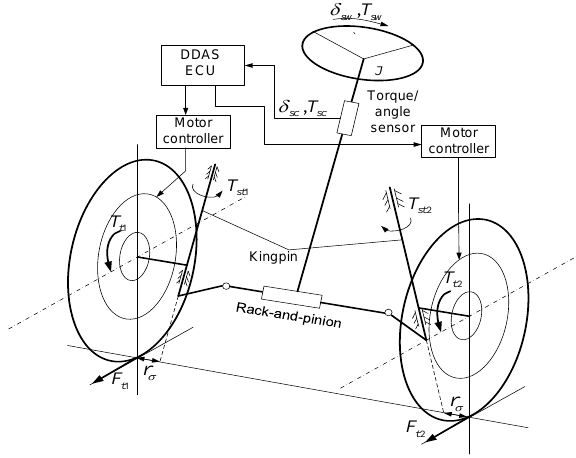
Figure 1. Working principle diagram of a di ff erential drive assist steering (DDAS) system.